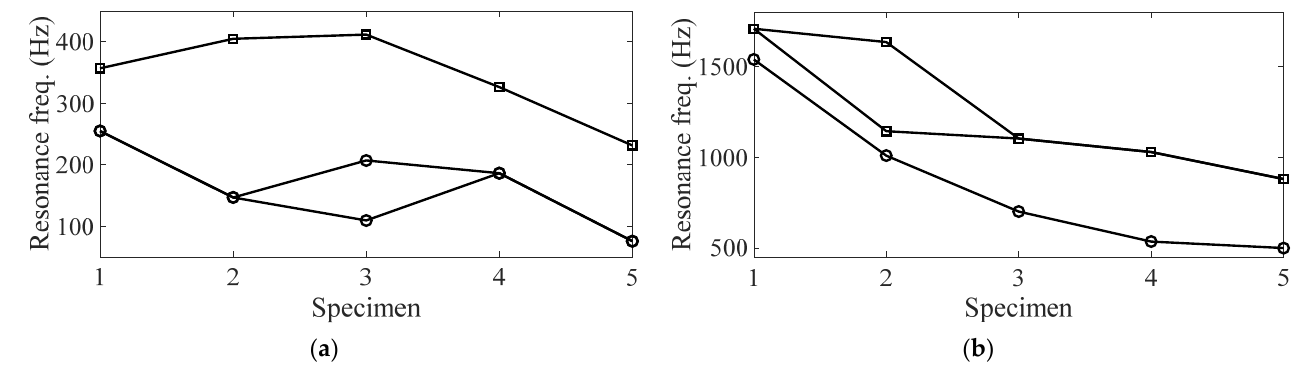
Crystals 2021 , 11 , x FOR PEER REVIEW Figure 6. Variations in resonance frequencies according to the carbon fiber direction: ( a ) Figure 6. Variations in resonance frequencies according to the carbon fiber direction: ( a ) Figure 6. Variations in resonance frequencies according to the carbon fiber direction: ( a ) Figure 6. Variations in resonance frequencies according to the carbon fiber direction: ( a ) Figure 6. Variations in resonance frequencies according to the carbon fiber direction: ( a ) : first bending mode; Figure 6. Variations in resonance frequencies according to the carbon fiber direction: ( a ) Figure 6. Variations in resonance frequencies according to the carbon fiber direction: ( a )